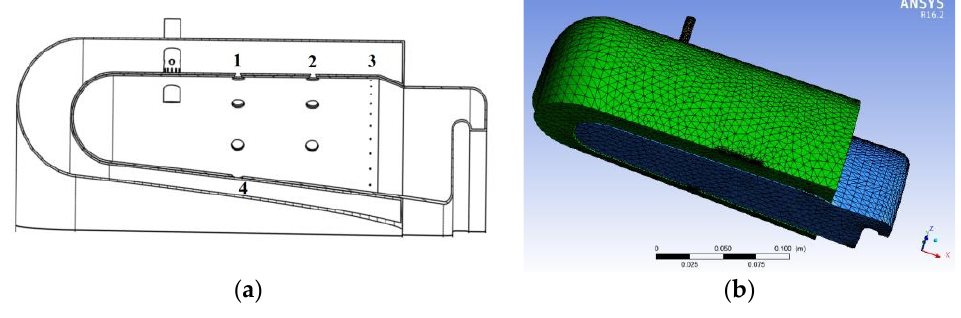
Figure 2. Combustor geometry ( a ) and mesh ( b ).